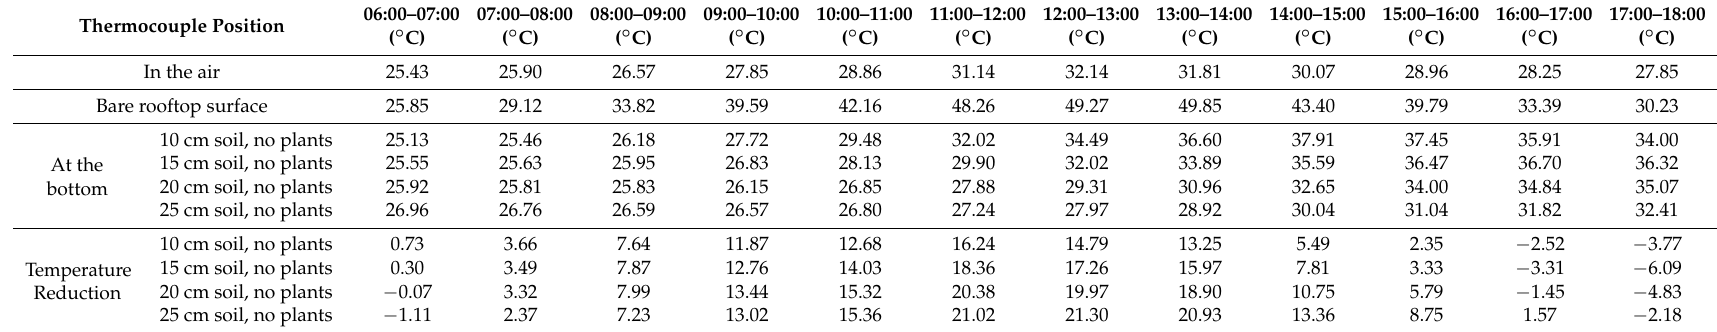
Table 3. Temperature at the bottom of the roofs and temperature reductions in the cases of 10, 15, 20, and 25 cm conventional garden-soil roofs without plants (14 May 2017 05:59:44 to 14 May 2017 17:49:44). Thermocouple Position